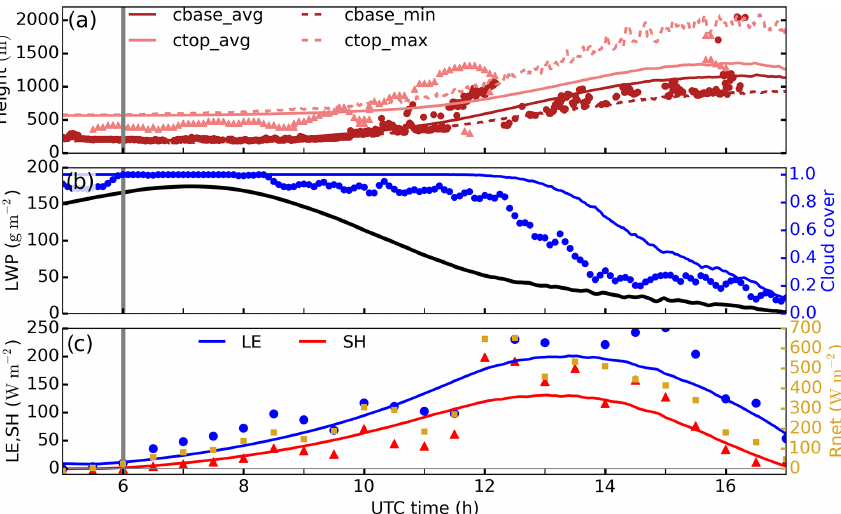
Figure 2. Time series of the domain-average cloud base (cbase_avg as solid dark red line) and cloud top (ctop_avg as solid light red line), maximum cloud top (ctop_max in dashed light red line) and minimum cloud base (cbase_min in dashed dark red line) (a) , liquid water path and cloud cover (b) , and latent and sensible heat fluxes as well as net radiation (c) in REF. Observed cloud base and cloud top heights on 26 June are represented by dark red circles and light red triangles, respectively, in (a) . Observed cloud cover, averaged over 19 campaign days is shown in blue circles in (b) . Observed latent and sensible heat fluxes are shown by blue circles and red triangles, respectively, and net radiation in yellow squares in (c) . The vertical grey lines indicate the sunrise time.